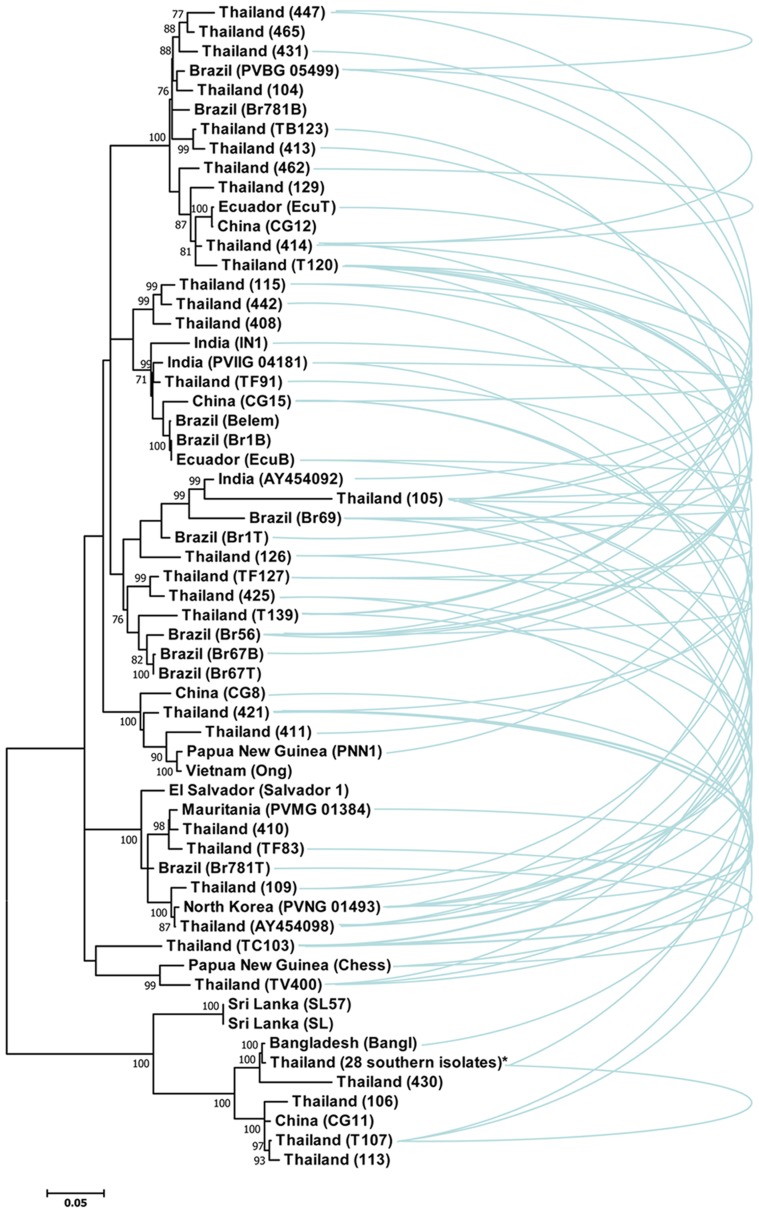
Phylogenetic tree inferred from aligned positions of PvMSP3β using the Maximum Likelihood method based on the General Time Reversible model.The tree with the highest log likelihood (−19878) is shown. The tree is drawn to scale, with branch lengths measured in the number of substitutions per site. The bootstrap values greater than 75% are shown along the branch. Isolate names (or accession numbers) are listed in parentheses after their geographic origins. “28 southern isolates” are those from Yala (n = 9) and Narathiwat Provinces (n = 19). Recombination events between sequences based on the RDP4 algorithms are shown as blue curved lines connecting between isolates.